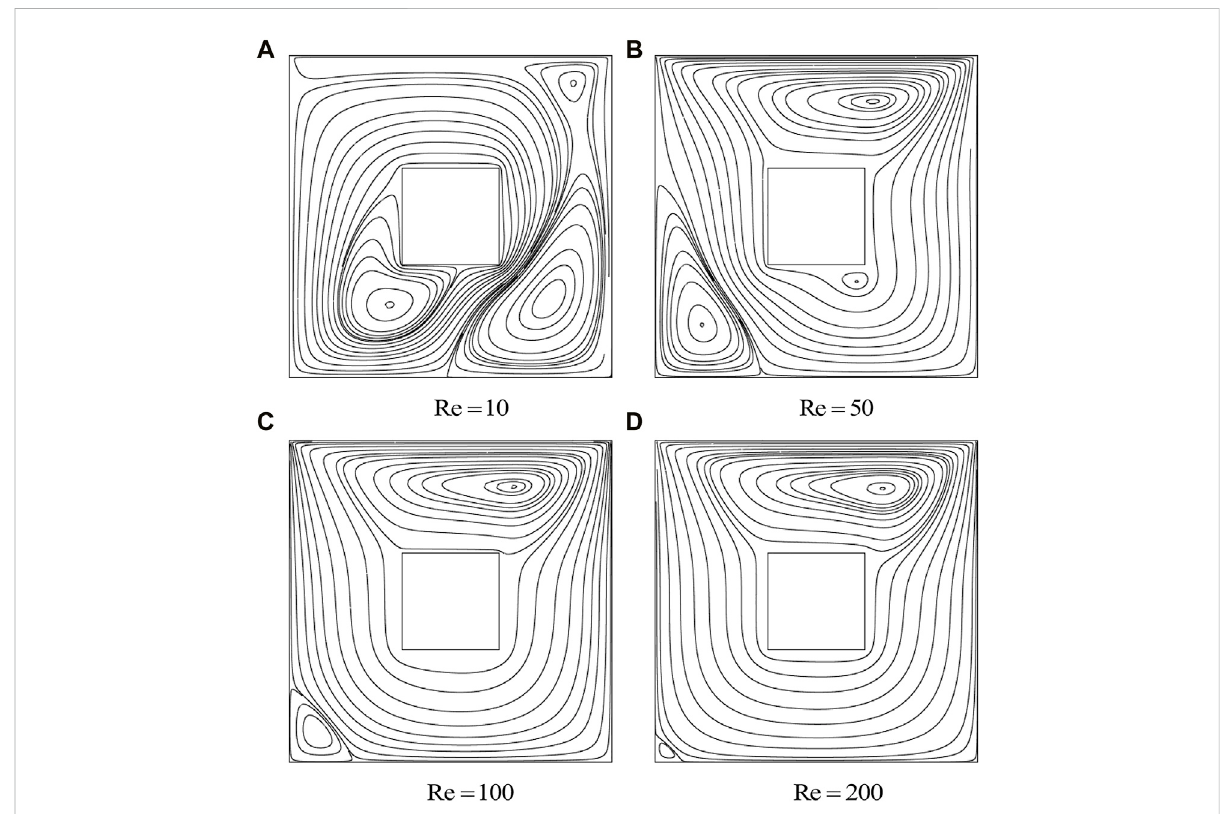
FIGURE 13 In fl uence of Re on isotherms with a non-uniformly heated bottom wall: adiabatic cylinder with a (cid:2) 20and Gr (cid:2) 10 4